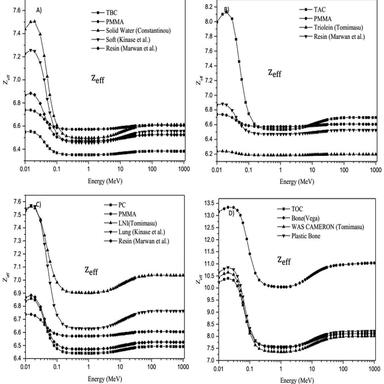
A) Zeff of soft tissues substitutes. B) Zeff of tissue substitutes to adipose tissue C) Zeff of tissue substitutes to the lung D) Zeff of tissue substitutes to cortical bone tissue in an energy range of 10 keV to 1 GeV determined by the Auto-Zeff software.